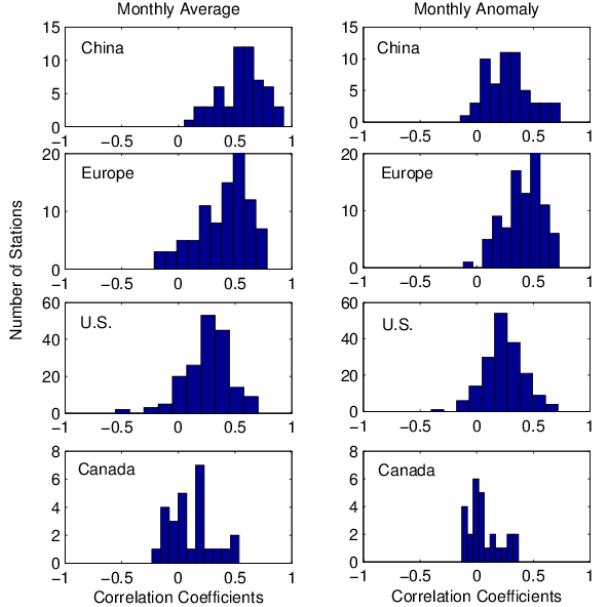
Fig. 7. Left column: the histograms of correlation coefficients, com- Figure 7. Left column: the histograms of correlation coefficients, computed at puted at each station, between monthly averages of PM 10 and op- each station, between monthly averages of PM10 and optical extinction tical extinction coefficients (inverse of visibility); right column: coefficients (inverse of visibility); right column: same as left column except that same as left column except that correlation coefficients are between monthly anomalies. Regions are as indicated in each panel. Data used here are the same as those used in Figs. 9 and 10.